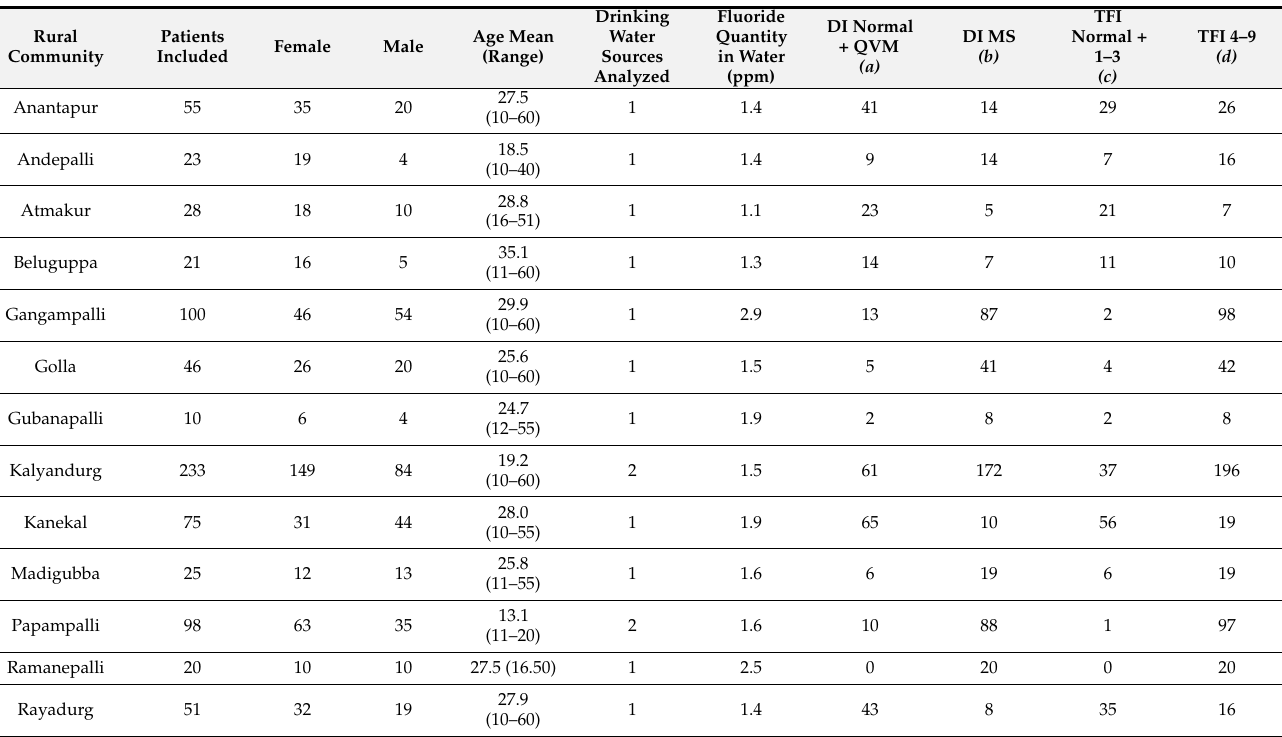
Table 1. Rural population distribution, fluoride quantity in water, and fluorosis index observed considering the Dean index (DI) and the Thylstrup and Fejerskov index (TFI) N =